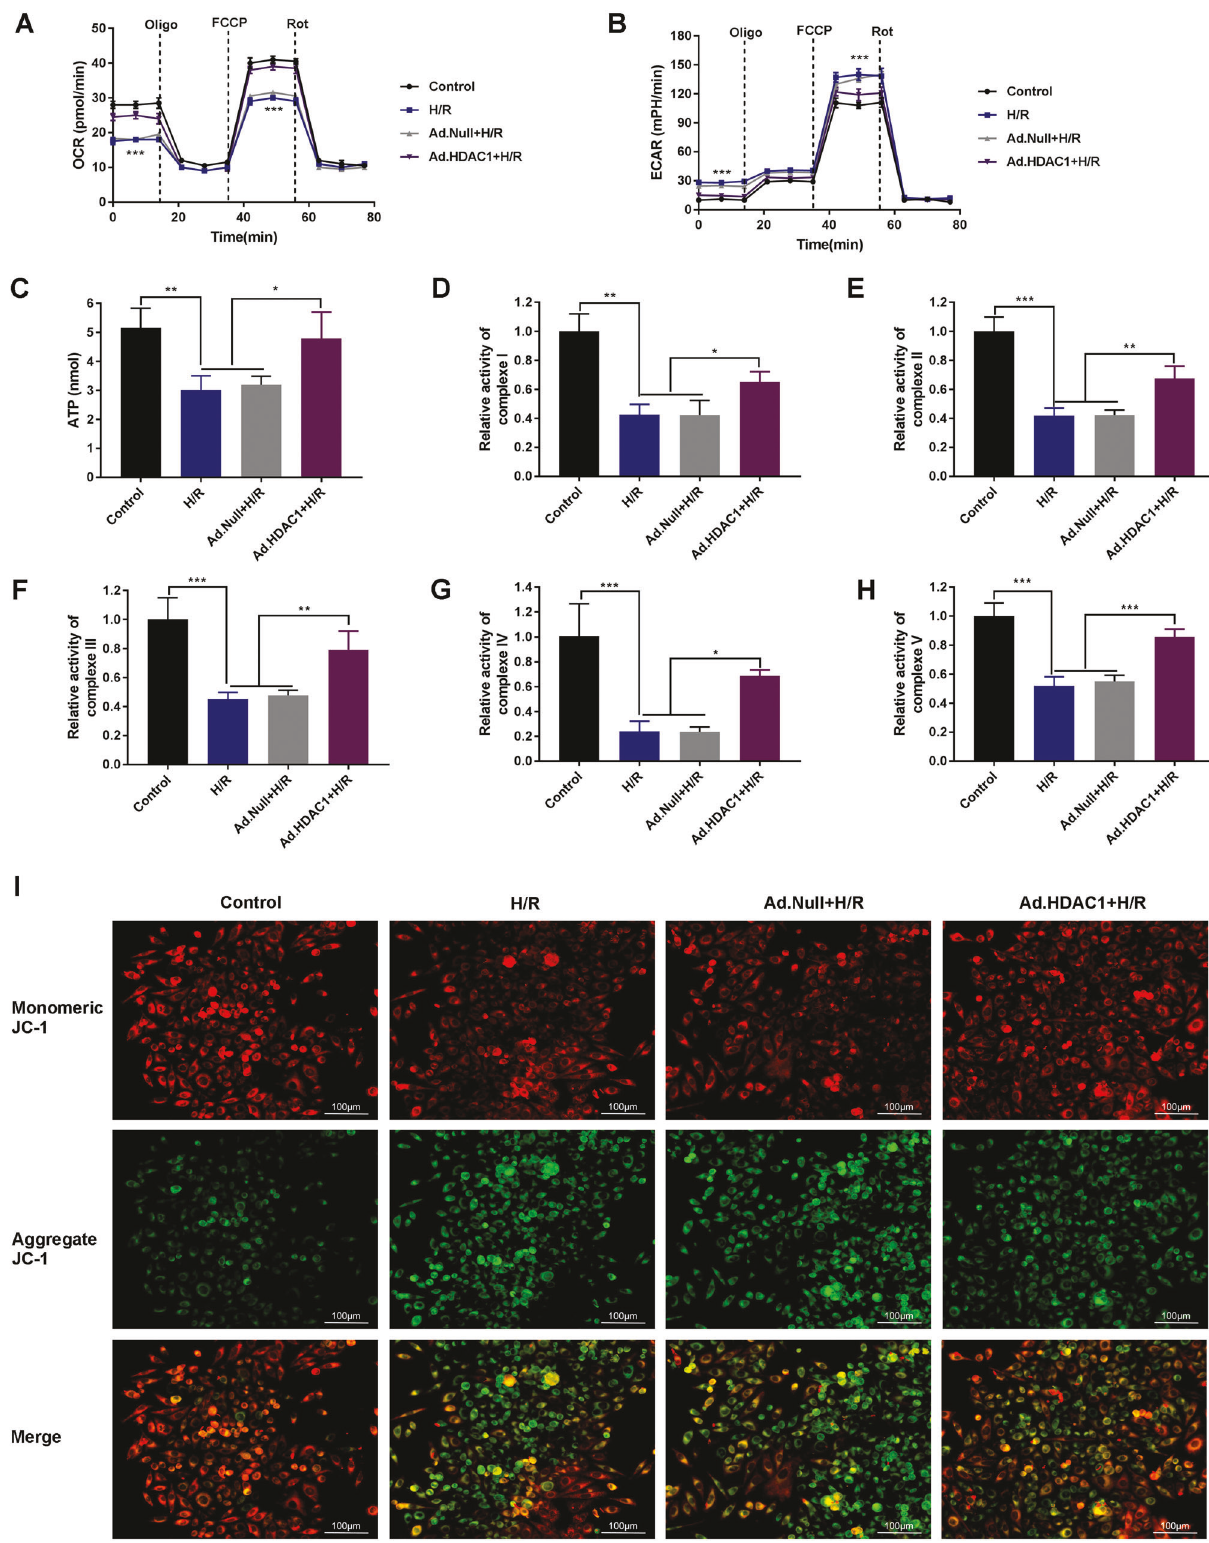
expression (Fig. 2K). Collectively, these data suggest that the inhibition of HDAC1 ameliorates macrophage in fl ammation in response to